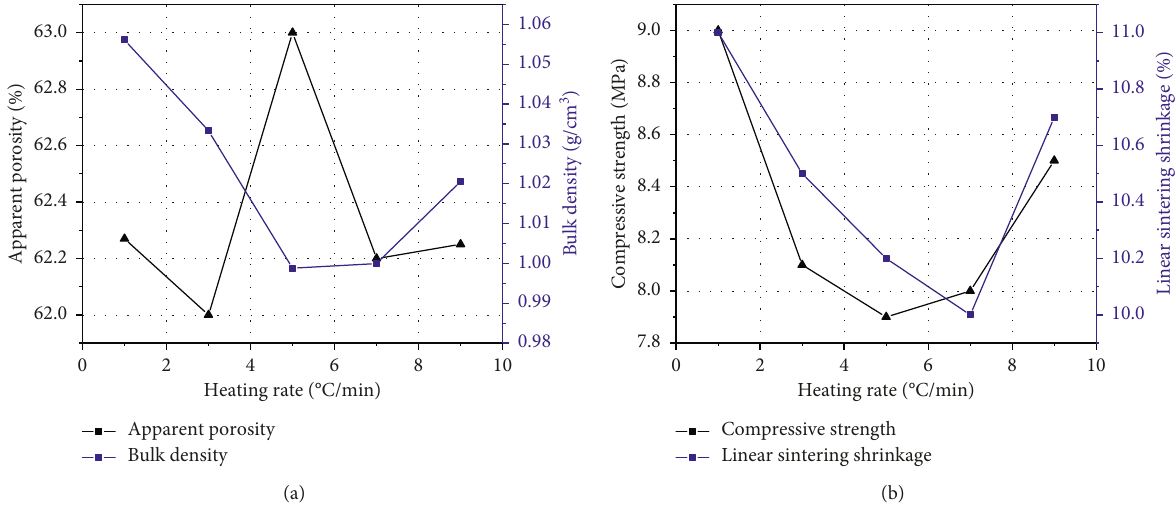
Figure 6: The influence of the heating rate on (a) the apparent porosity and bulk density and (b) compressive strength and linear sintering shrinkage of as-sintered ceramics for one-stage sintering